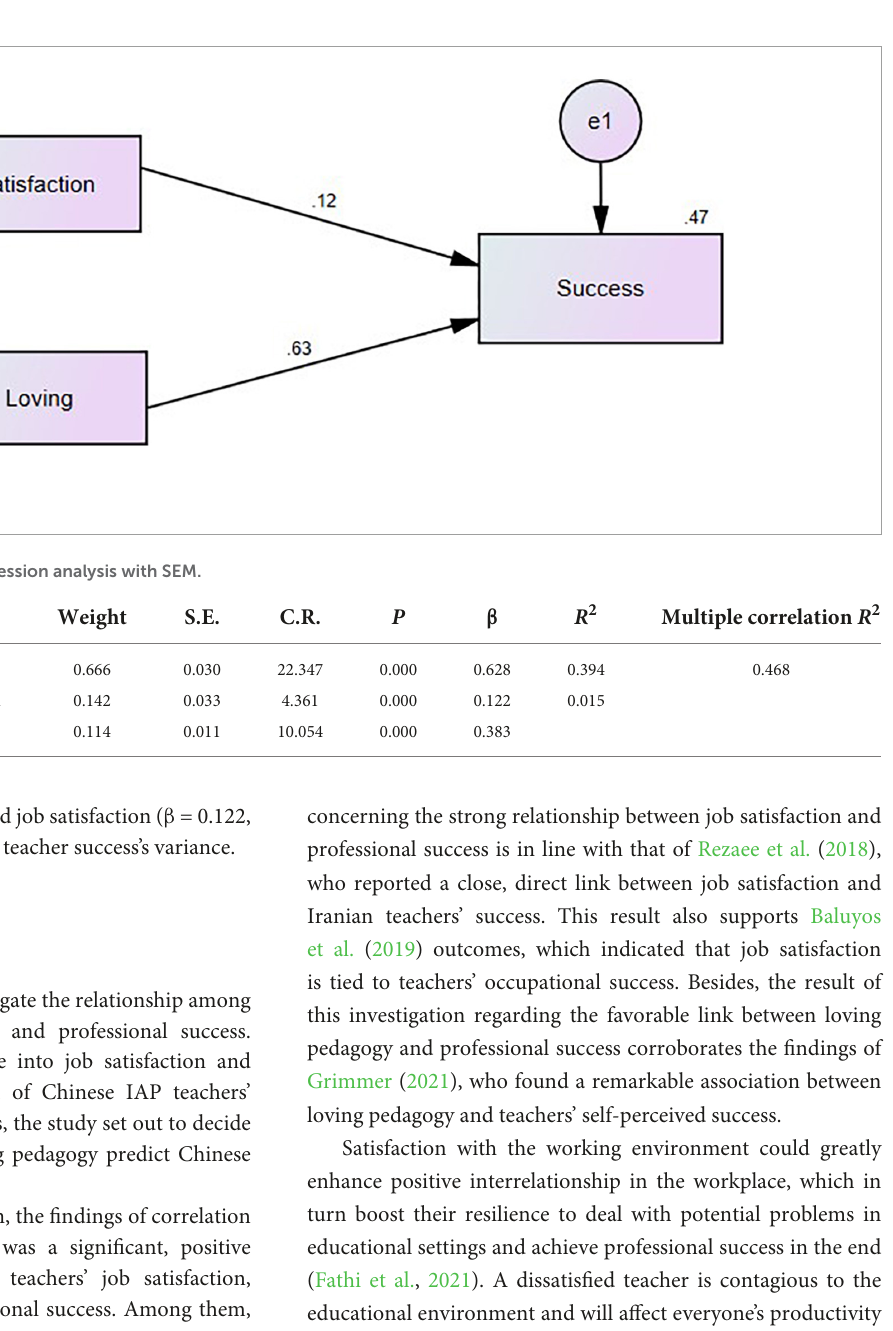
FIGURE2 The final measurement model.